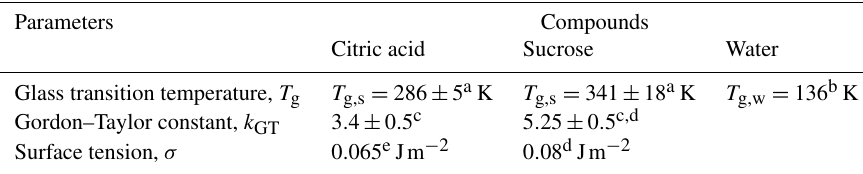
Table 1. Model parameters. Parameters Compounds Citric acid